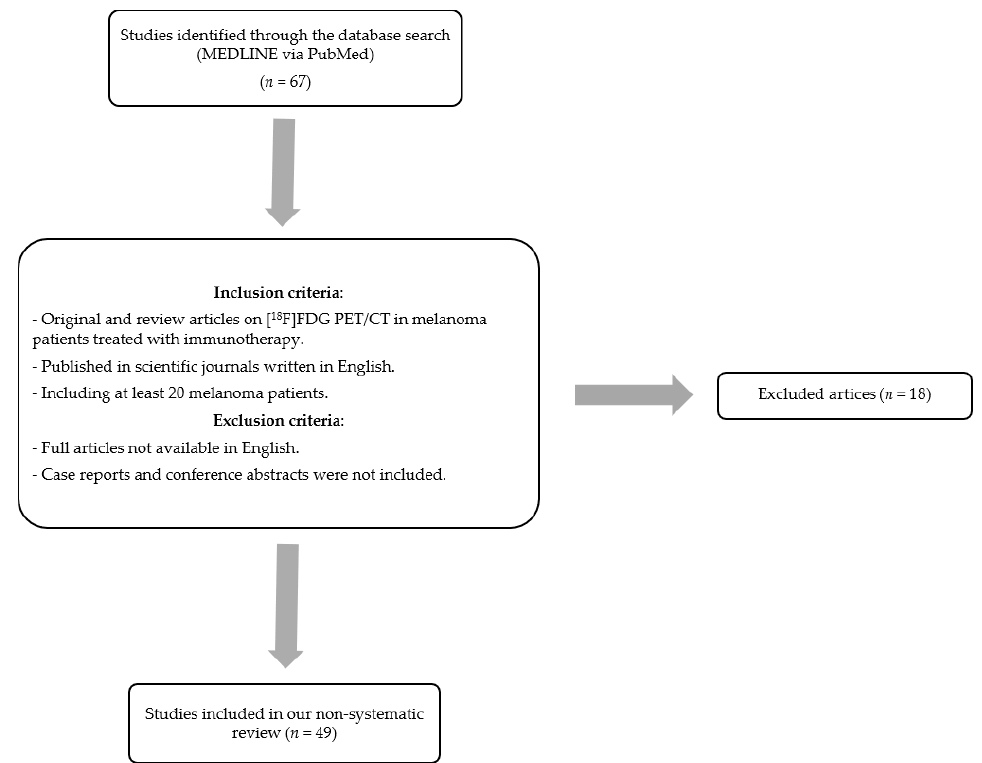
Figure 1. Flow chart of study selection.